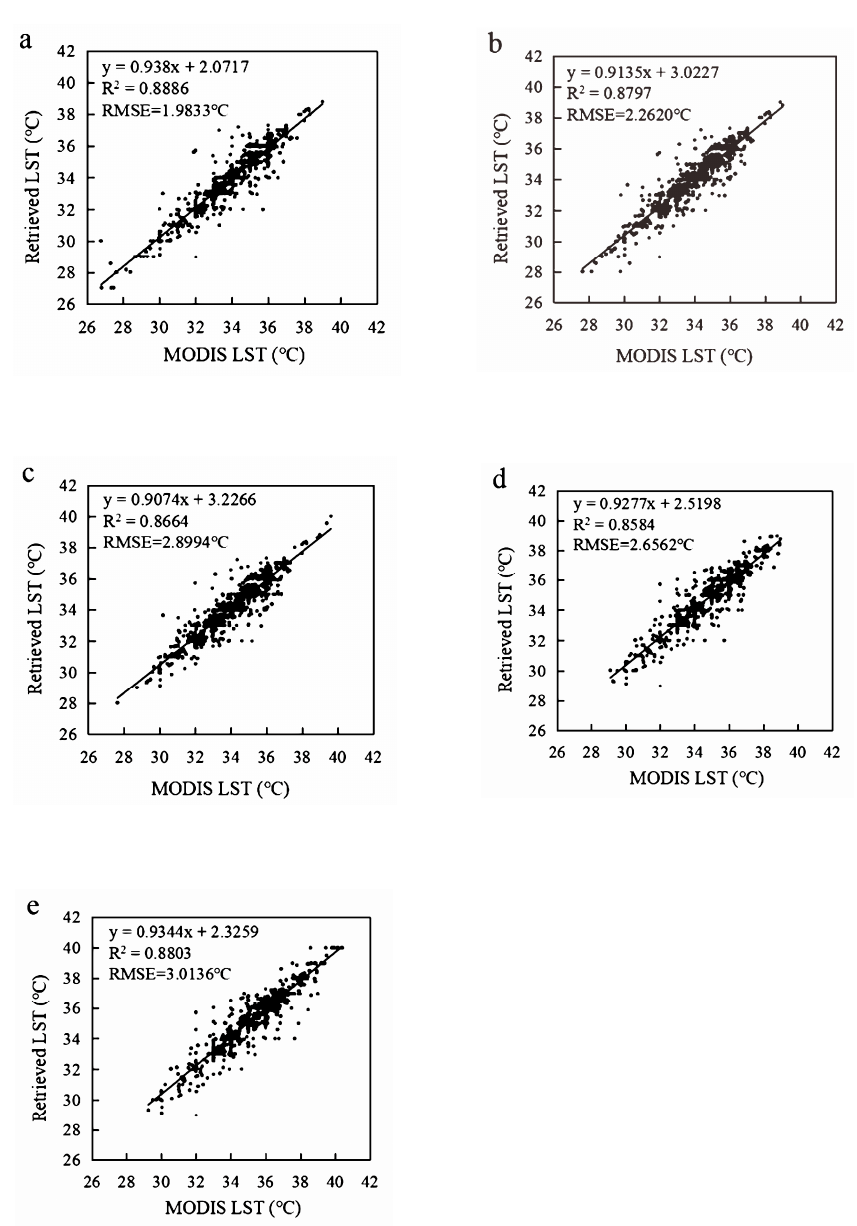
Figure 4. MODIS LST downscaling precision evaluation. (( a – e ): 2000, 2005, 2010, 2015,